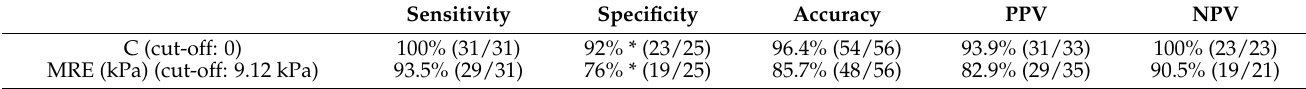
Table 5. Statistical value from differentiation between HCC and